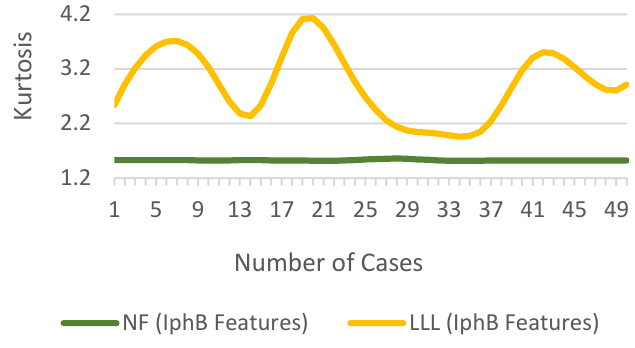
Figure 13. Kurt of Iph B for NF and fault